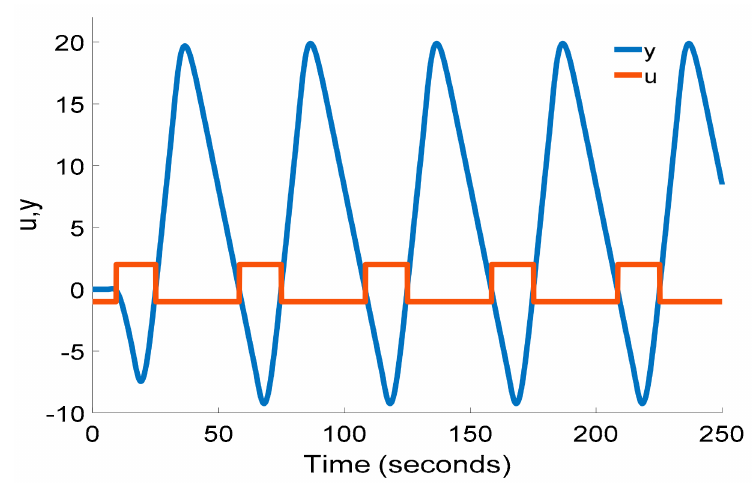
Figure 17. The relay output u and the observed output y of the process P 4 ( s ).